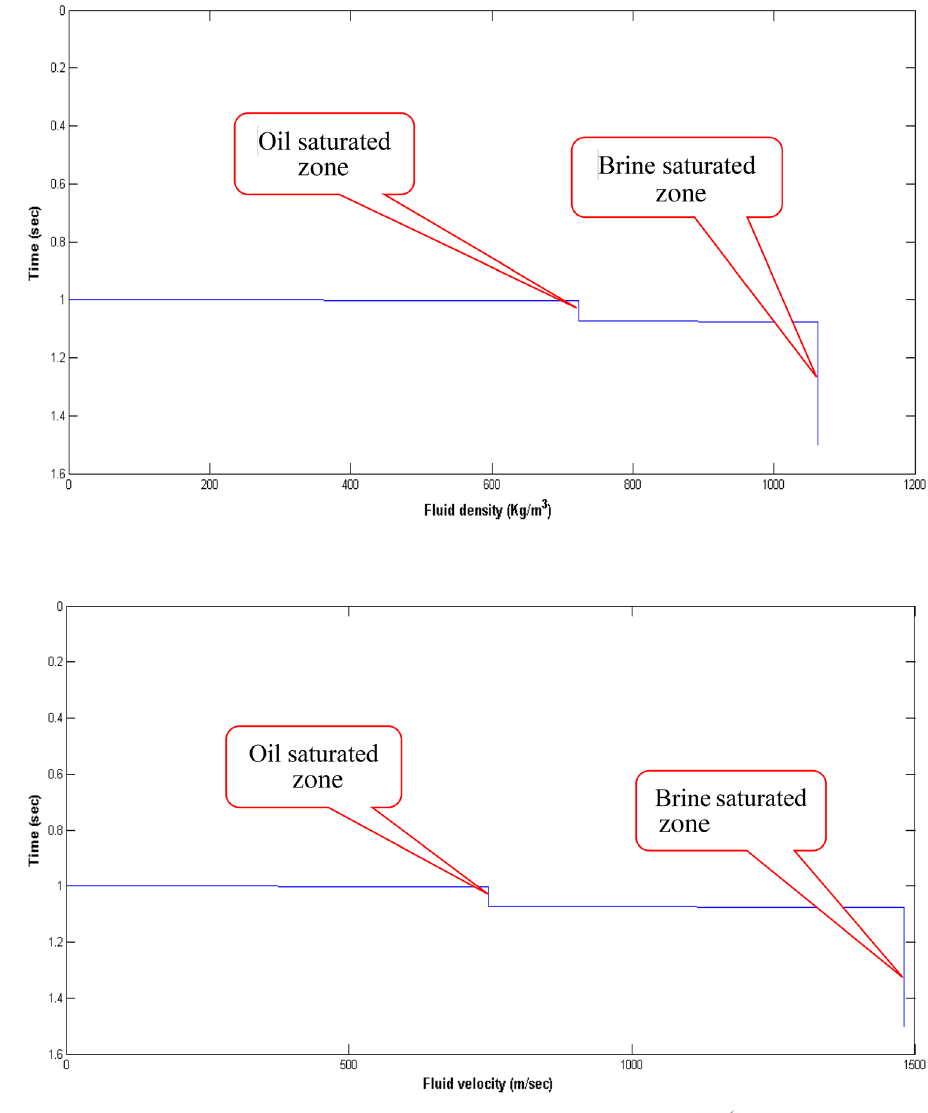
Fig. 11 Fluid density plot with 10% porosity of Arab formation